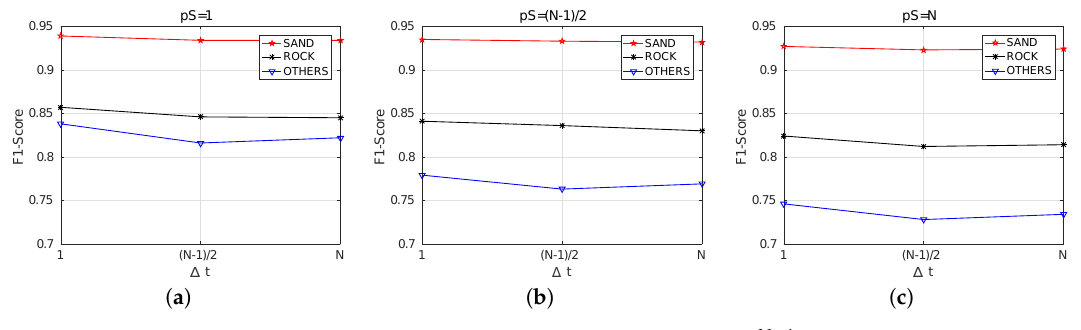
Figure 12. F1-Scores for SCM training with ( a ) pS = 1, ( b ) pS = N − 1